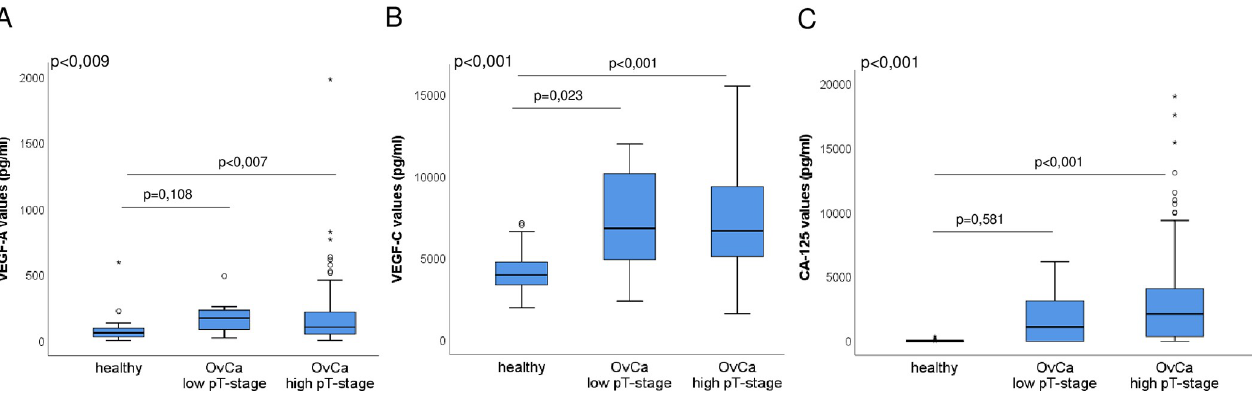
Fig 2. VEGF-A, -C and CA-125 serum levels in healthy and ovarian cancer patients. Box plots showing serum levels of VEGF-A (A), VEGF-C (B) and CA- 125 (C) in healthy people and ovarian cancer patients with low and high stages. Two types of outliers: out values and extreme (far out) values in box plots were marked with small circle and star respectively.